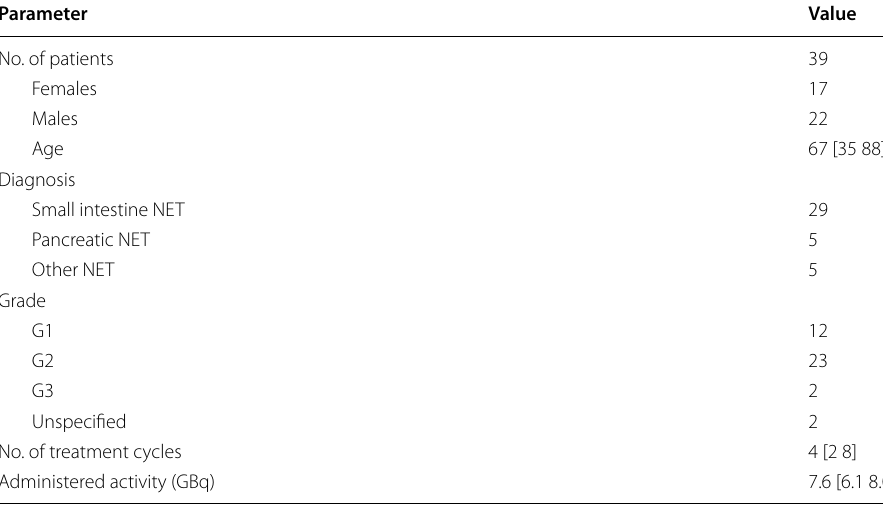
Table 1 Patients characteristics [mean (range) where applicable] Parameter